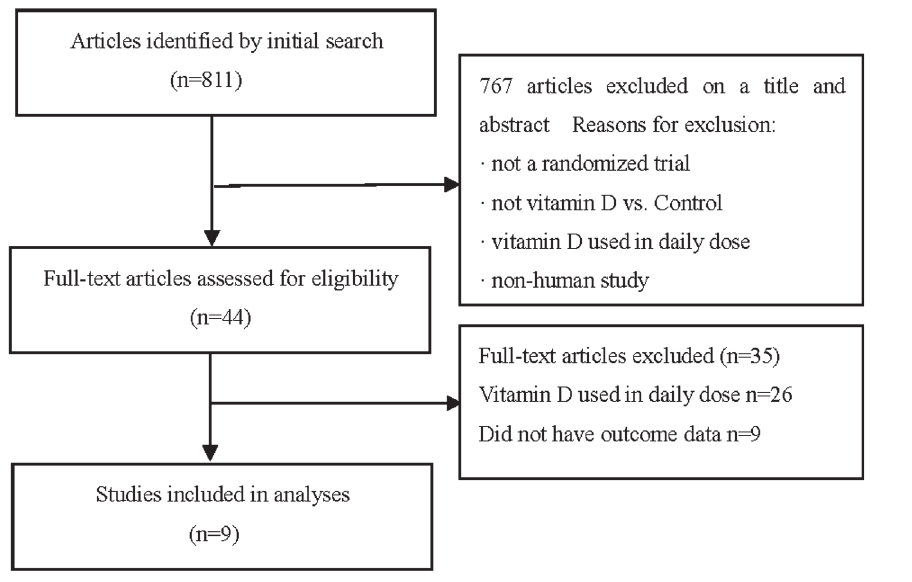
Figure 1. Study flow